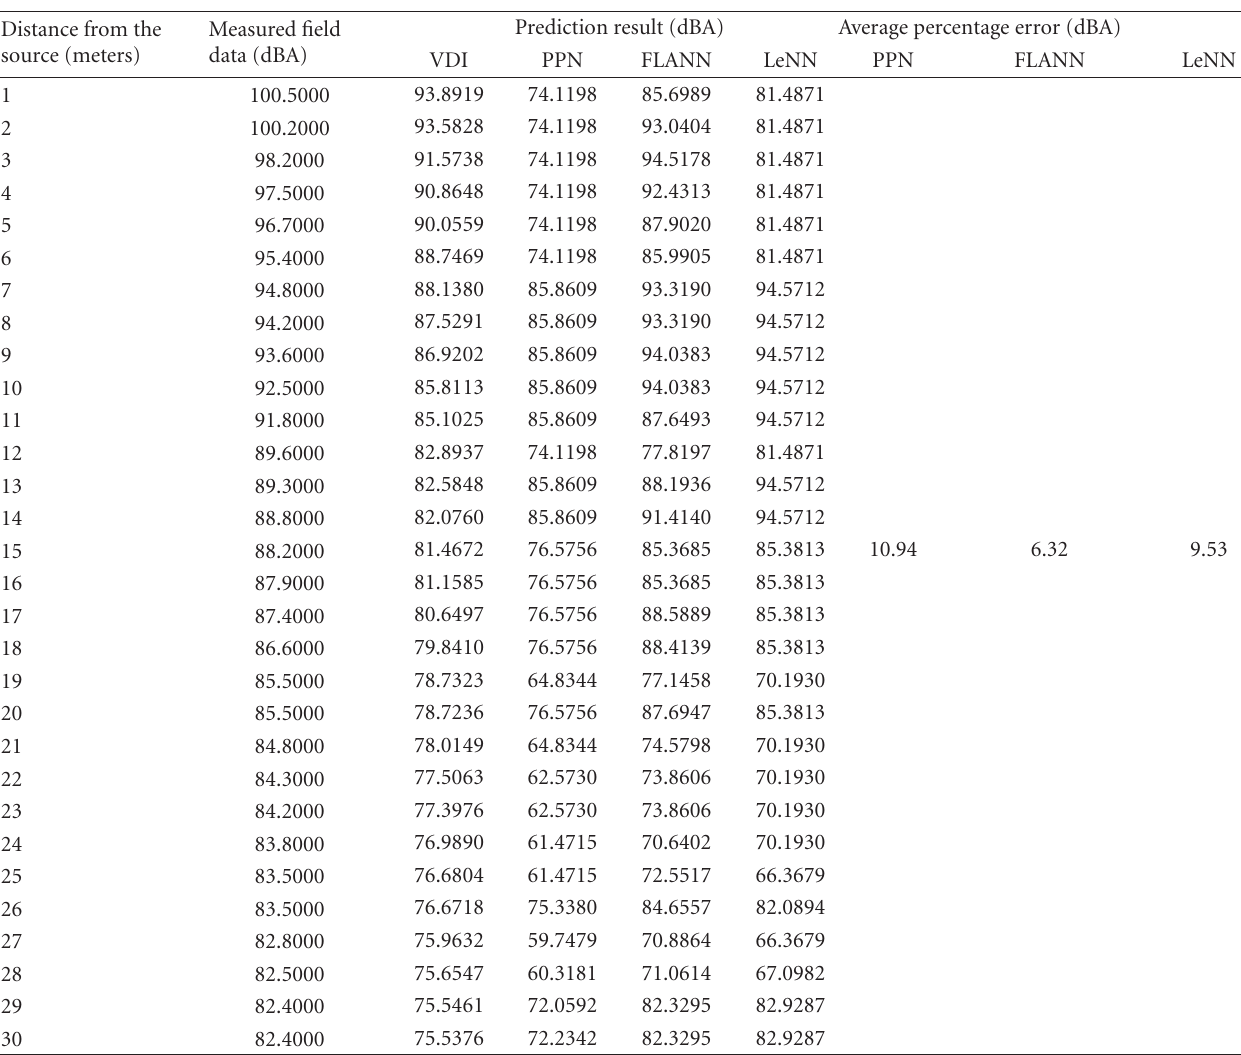
Table 5: Simulation study of dozer